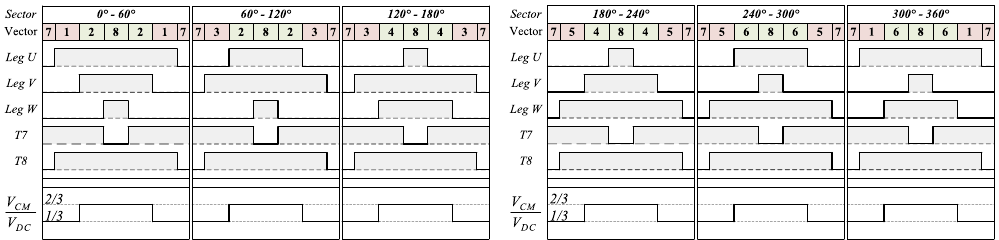
Figure 9. Vectors usage and switch pulse pattern throughout the rotational period for the SVPWM. Only one PWM period is presented. Red represents the odd vectors, whereas green the even